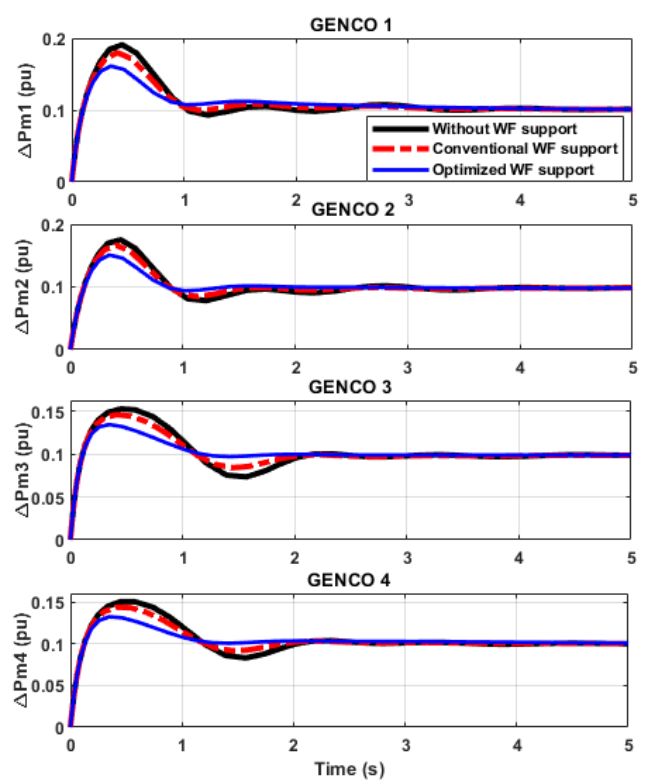
Figure 12. Change in power generation of GENCOs in a Poolco transaction.